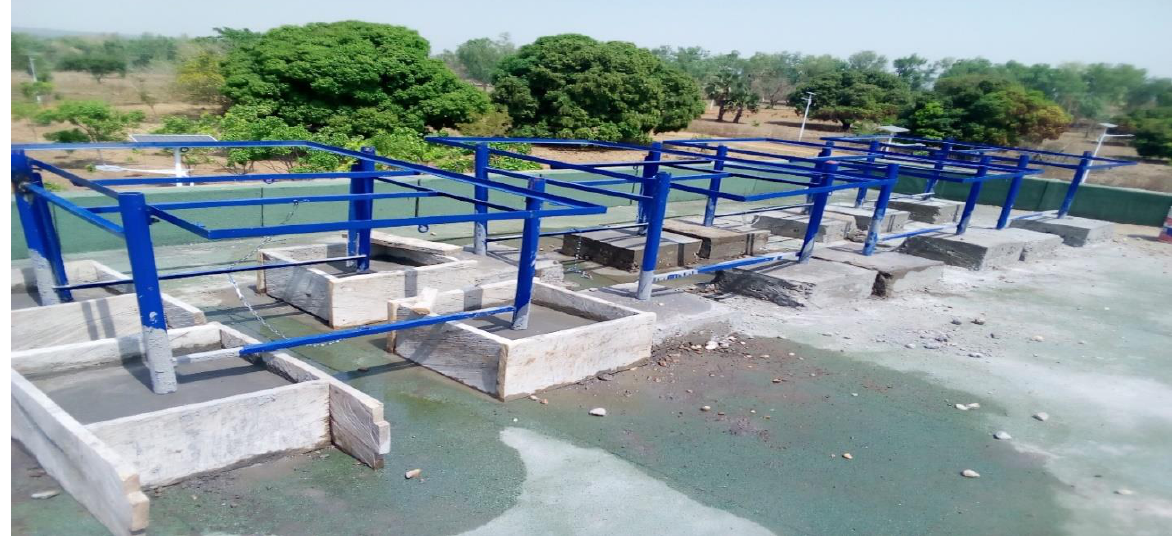
Figure 4: Installation of metal structures